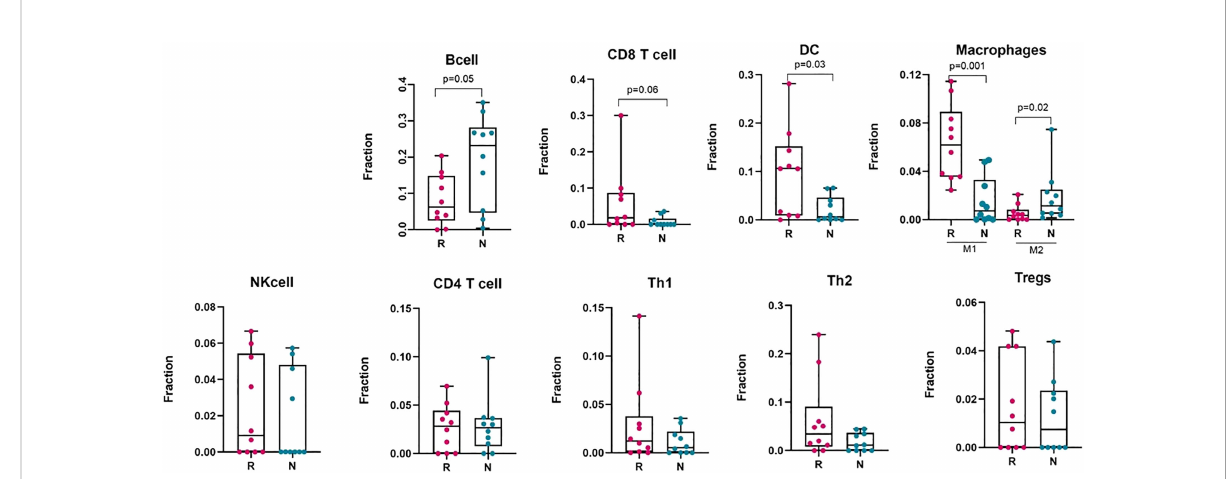
FIGURE 4 Deconvolution study to estimate different immune cell abundance in responding (n = 10) and non-responding (n = 10) melanoma tissues. Signi fi cance tests were performed using Mann – Whitney U test. Here, R, responder; N, non-responder, DC, dendritic cells; NK cell, Natural killer